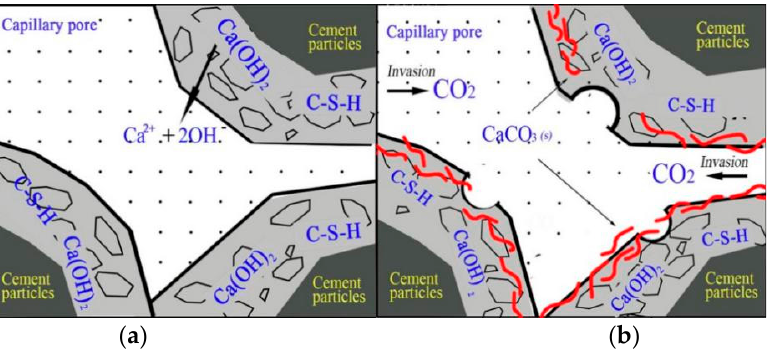
Figure 13. Carbonation mechanism of ordinary concrete: ( a ) Non carbonized; ( b ) After carbonization.